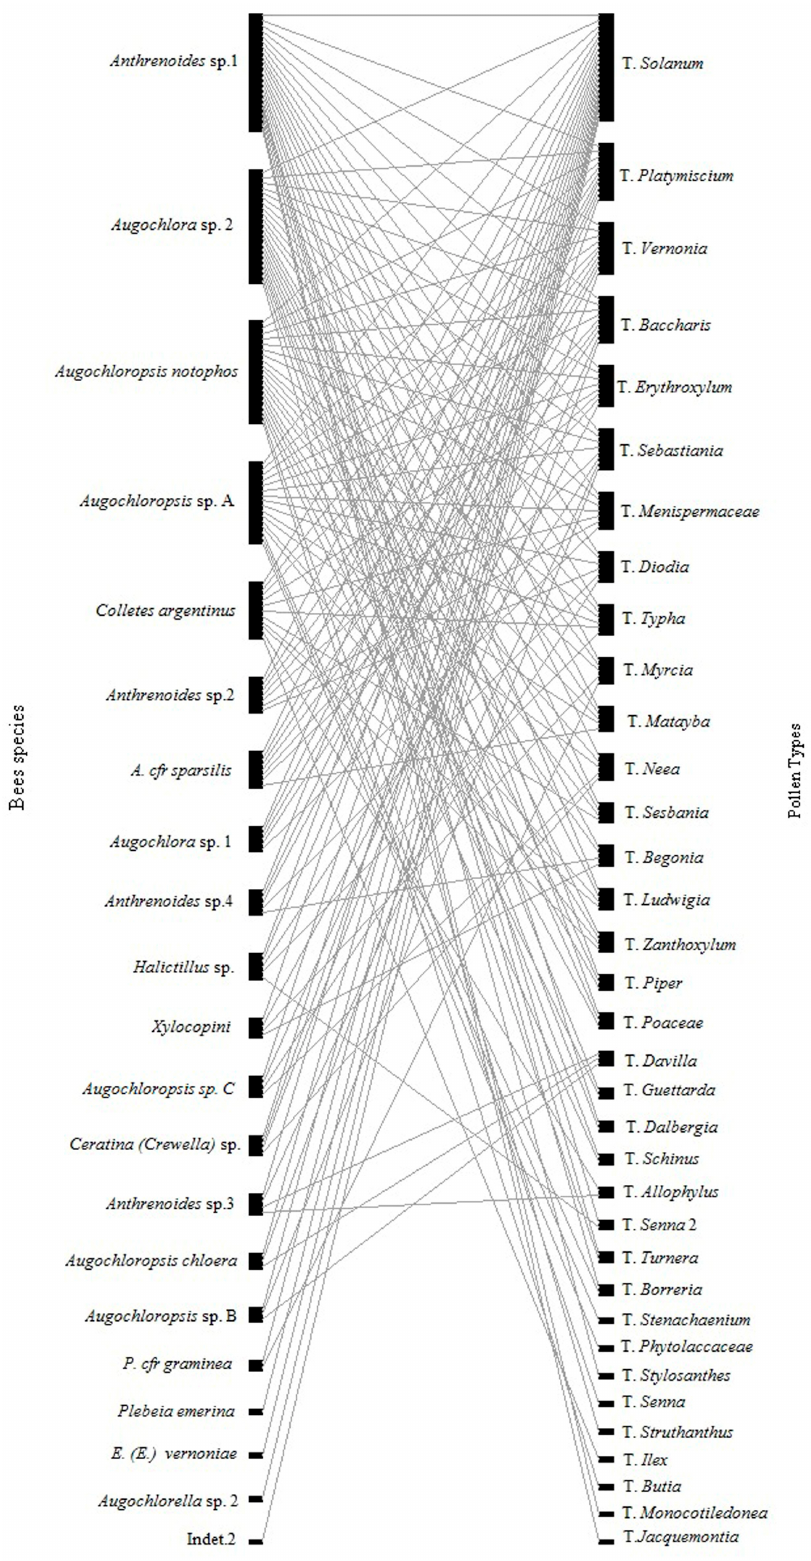
Figure 4. Eulerian graph representing the interaction networks between pollen types and floral visitor bees of Solanum didymum . The binary matrix qualitatively demonstrates the interactions between species, where A. cfr sparsilis = Augochloropsis cfr sparsilis , P. cfr graminea = Pseudaugochlora cfr gramínea , E. (E.) vernoniae = Exomalopsis ( Exomalopsis ) vernoniae, Indet. 1 = Indeterminate1, T. = Type.